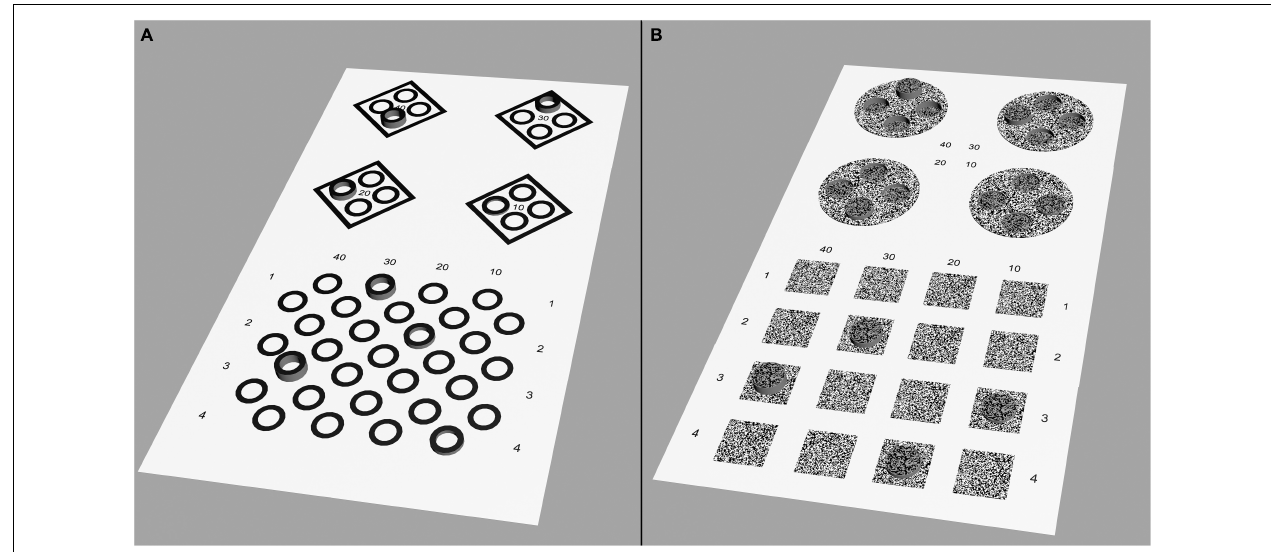
FIGURE 2 | Simulation of the perceptions generated by the test images. If a patient’s stereothreshold is lower than the displayed disparity, the target appeared as protruding. (A) Contour-based pattern comparison test between four circles arranged in quadrilateral form and vertical line form. The disparity of the four circles arranged in both formations was 40 (cid:48)(cid:48) , 30 (cid:48)(cid:48) , 20 (cid:48)(cid:48) , and 10 (cid:48)(cid:48) , respectively. (B) Random-dot pattern comparison test between four circles arranged in quadrilateral and vertical line forms. The disparity of the four circles arranged in both forms was 40 (cid:48)(cid:48) , 30 (cid:48)(cid:48) , 20 (cid:48)(cid:48) , and 10 (cid:48)(cid:48) , respectively. In the quadrilateral arrangement, the other three circles had the same amount of disparity as the target but were designed to be uncrossed and appeared dented into the planes.